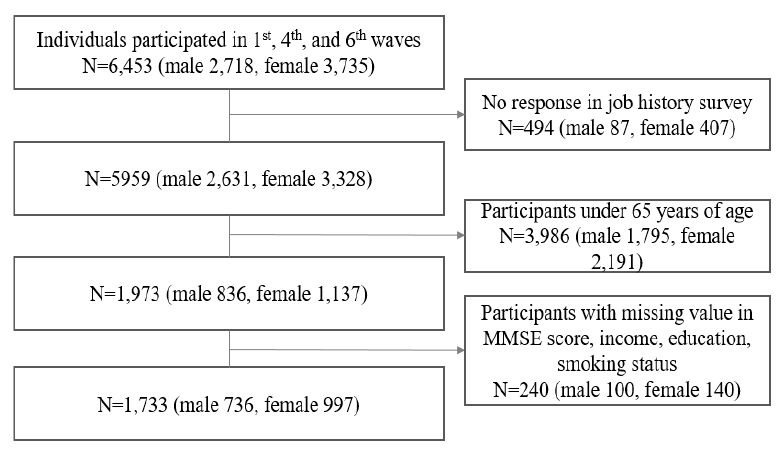
Figure 1. A flow chart of study population ( N = 1733; male 736, female 997).